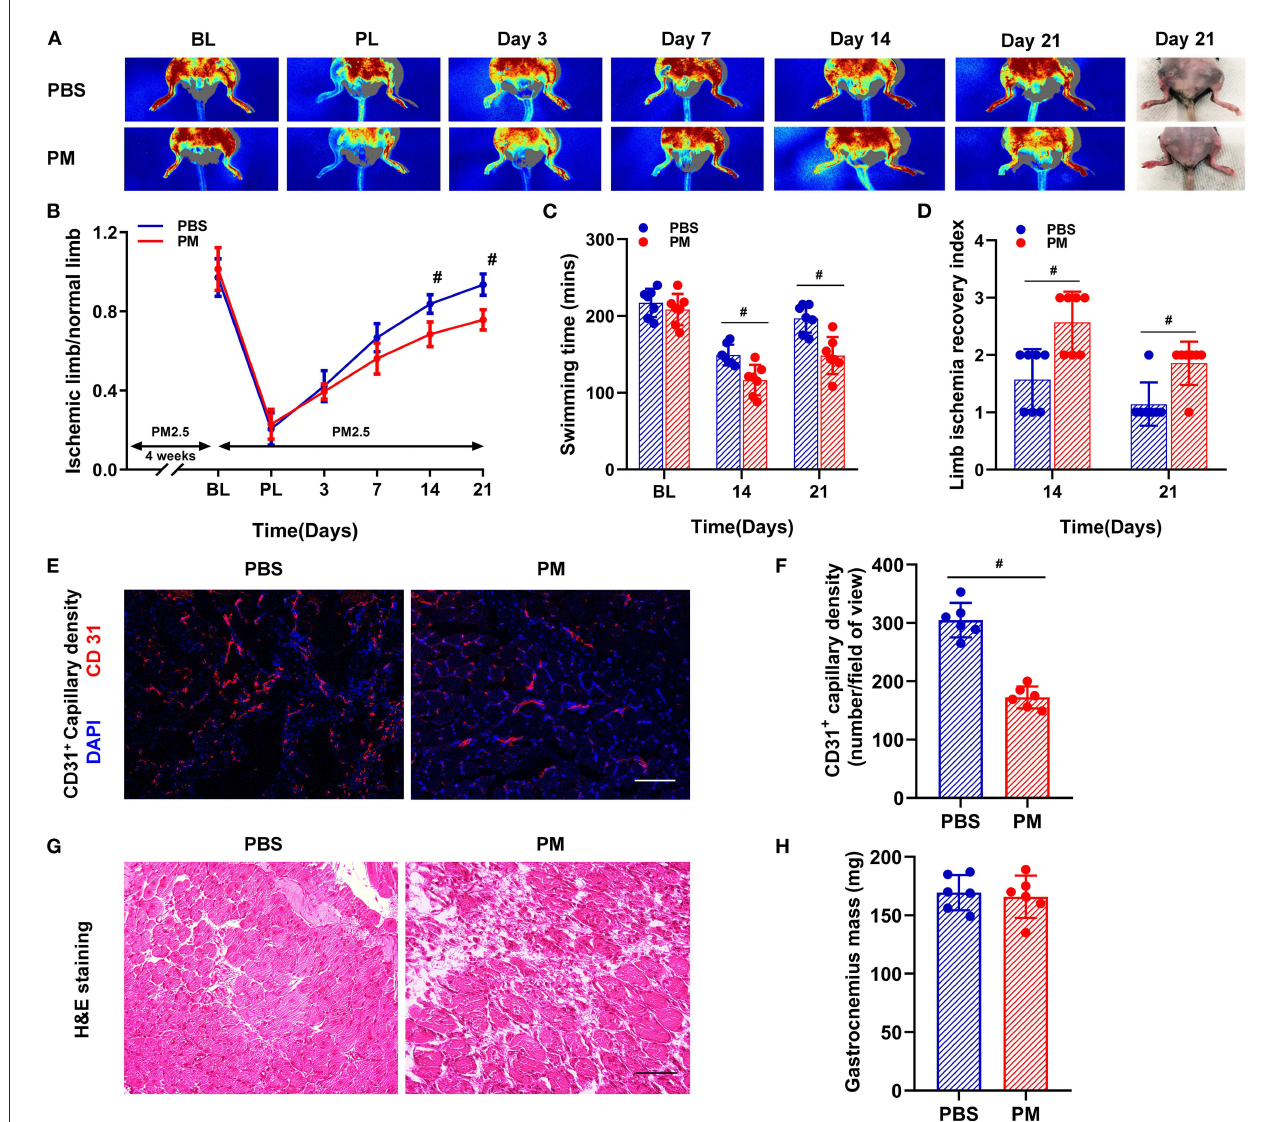
FIGURE1 Circulatory and functional recovery of the ischemic limb was attenuated in mice with PM exposure. Recovery of blood flow in the ischemic limb was evaluated by measuring the ratio of ischemic (right) limb blood perfusion/normal (left) limb blood perfusion. PM exposure significantly decreased the recovery of blood flow in C57BL/6 (WT) mice at days 14 and 21 [ # p < 0.01, (A, B) ]. The mechanical function of the ischemic limb was evaluated using a swimming endurance test and a semi-quantitative assessment of ambulatory impairment and limitation of the ischemic limb (modified clinical standard score). As shown in (C, D) , there was a significant decrease in the recovery of mechanical function for mice treated with PM compared to control mice with PBS treatment at days 14 and 21 ( # p < 0.05). Gastrocnemius samples of the ischemic limb was harvested at day 21 after CLI for ex vivo histological analyses for capillary density, muscular mass, and inflammatory infiltration. As shown in (E, F) , CD31 + capillary density was significantly decreased in PM-treated mice compared to PBS-treated mice ( # p < 0.01). H&E staining showed that there was a significant increase in inflammatory cell infiltration in the ischemic limb in PM-treated mice compared to PBS-treated mice, while there was no significant change in muscle mass [ # p > 0.05, (G, H) ]. BL, before ligation; PL, post ligation; Scale bar, 50 µ m. n = 7/group. Statistical differences were determined with ANOVA followed by Tukey’s post hoc test or Student’s two-tailed